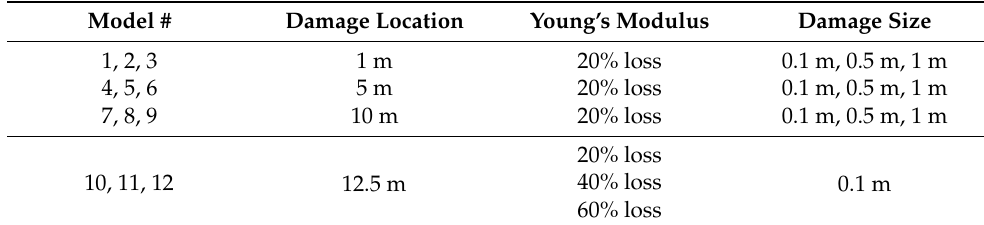
Table 1. List of damaged model conditions.